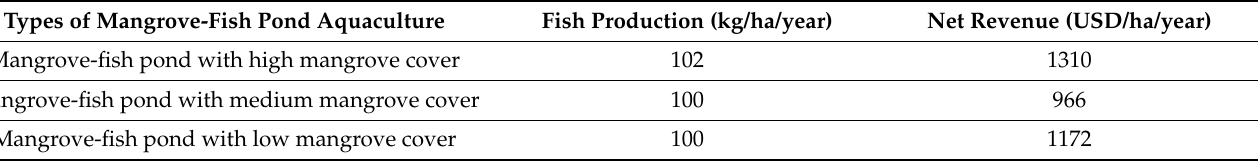
Table 4. Fish production and net revenue from mangrove-fish pond aquaculture in the study